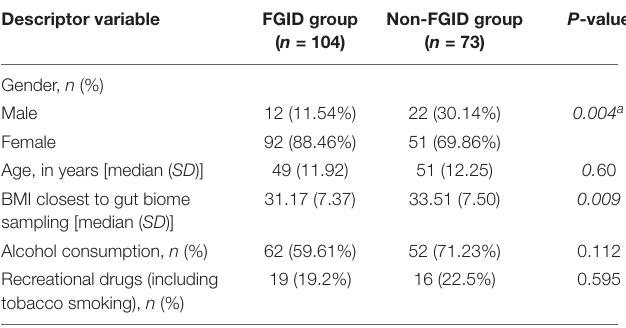
TABLE 3 | Functional gastrointestinal disorders vs. non-FGID logistic model: demographics + microbiome (D + M).